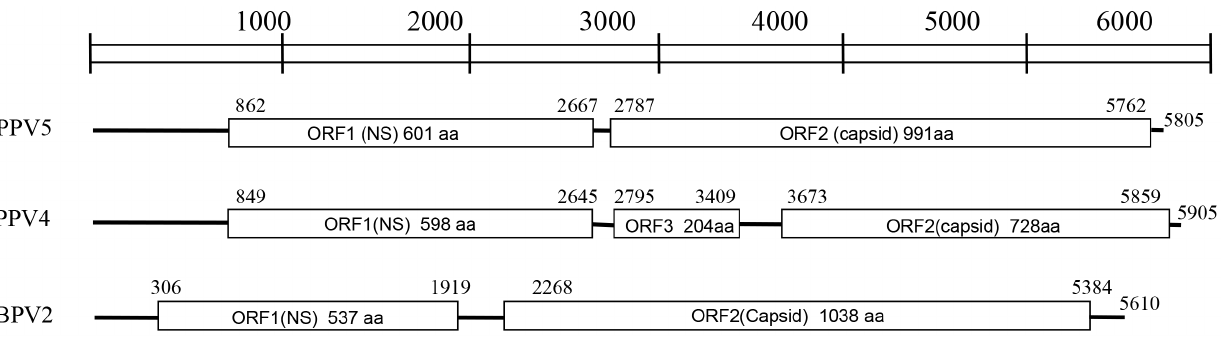
Figure 1. Schematic representation of the genomes of PPV5 compared with PPV4 and BPV2. The position and size of putative ORFs are indicated. The GenBank accession numbers of the reference sequences are JX896321 (PPV5), GQ387499 (PPV4), AF406966 (BPV2). aa: amino acid. NS: nonstructural gene.